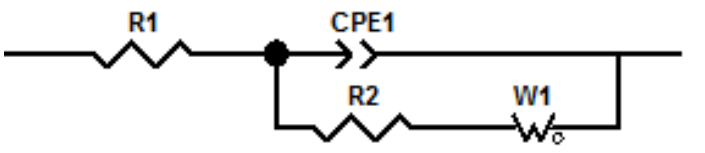
Figure 8. Equivalent circuit to model EIS data. R1 represents the resistance of the solution, R2 the resistance of the membrane, CPE1 is a constant phase element and W1 an open Warburg element. This circuit is based on two equivalent circuits used to model a PIM system like the one studied [14,18]. The Nyquist plots obtained for the membranes are presented in Figure 9. The adjustment of the data obtained through the equivalent circuit is presented